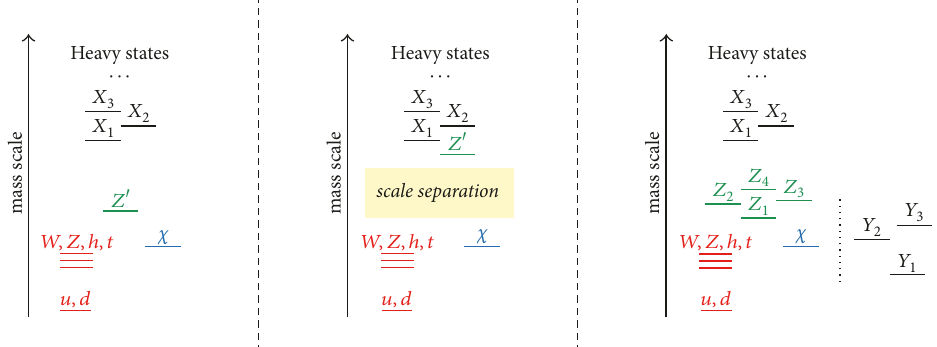
Figure 1: Left: a simplified model viewed as a sector of a more general new physics scenario. The SM is complemented by the DM particle 𝜒 and a mediator 𝑍 󸀠 . Other heavy states 𝑋 , 𝑋 ,𝑋 , . . . may be integrated out because they are very heavy. Centre: in the case in which the 1 2 3 mediator 𝑍 󸀠 itself has a very large mass, it may be integrated out as well and the interaction is mediated by effective operators. Right: in a generic setup the DM-SM interaction is mediated by a number of operators, possibly interfering with each other. Moreover, additional states 𝑌 ,𝑌 , 𝑌 , . . . that do not couple directly to DM may be present. Those states can constitute a new handle on the dark sector, other than DM. 1 2 3 The ‘less simplified’ models described in Section 4 fall in this